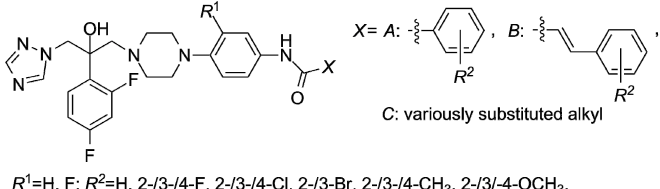
Figure 2. The N -arylpiperazine derivatives tested in vitro as the inhibitors of a lanosterol 14 α -demethylase (CYP51).